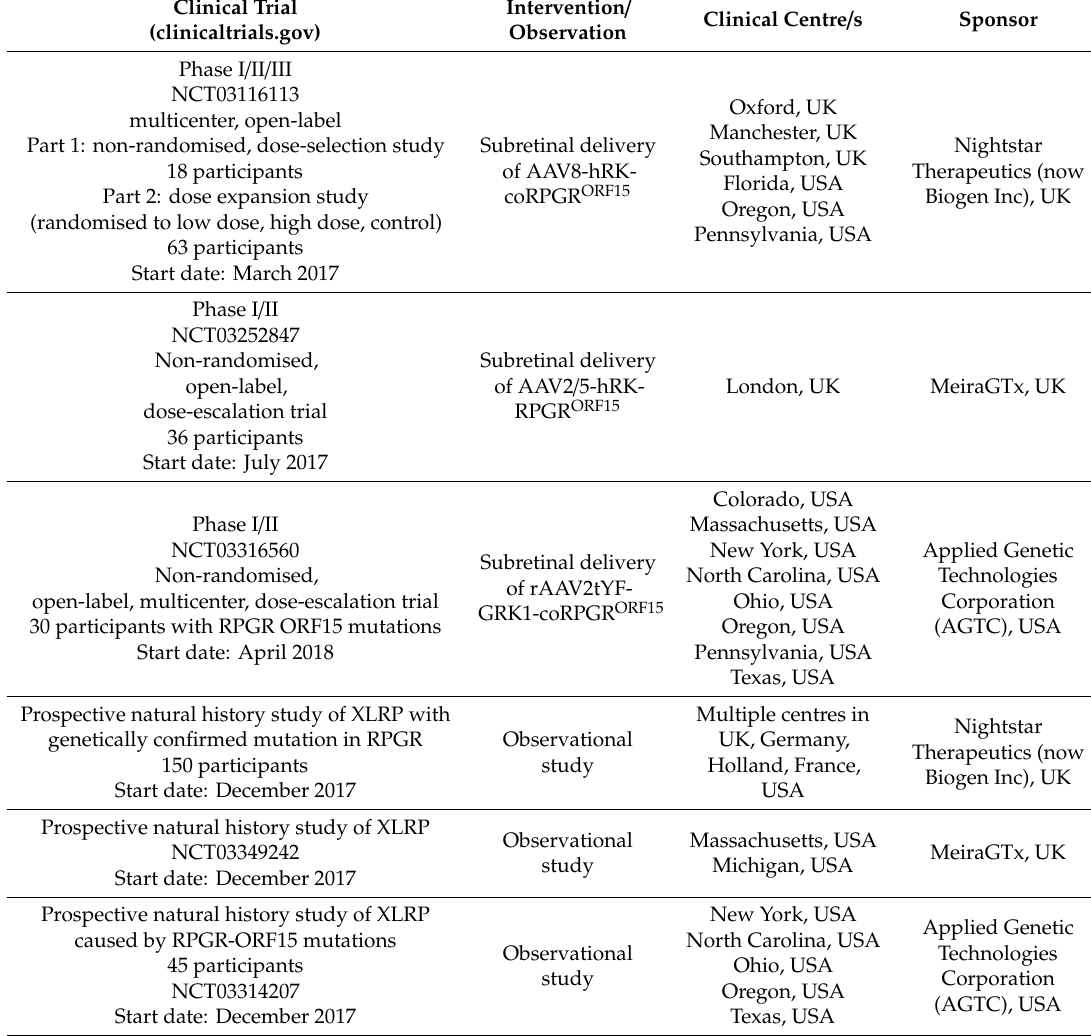
Table 2. Summary of clinical trials for RPGR-related X-linked retinitis pigmentosa